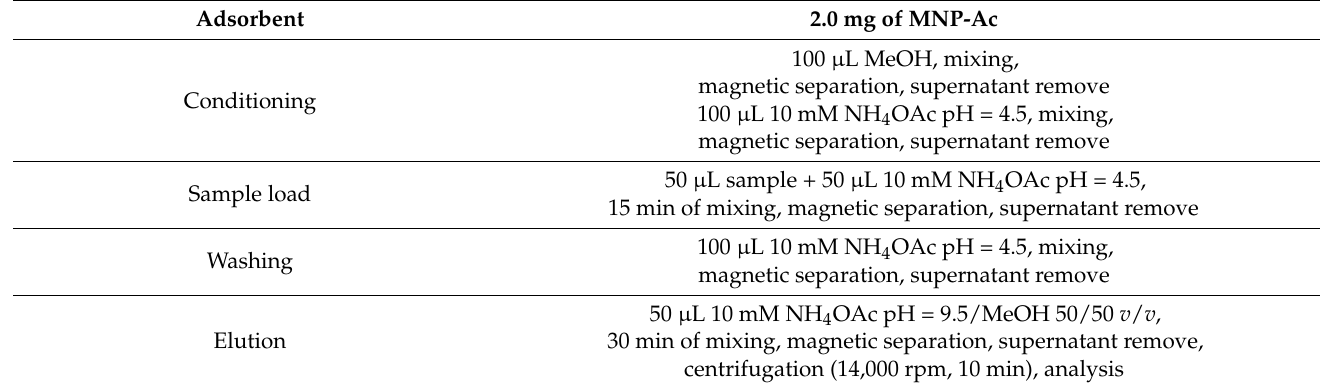
Table 4. The final procedure used for the MDSPE of modified and unmodified OGNs. Abbreviations: MeOH—methanol; NH 4 OAc— ammonium acetate.